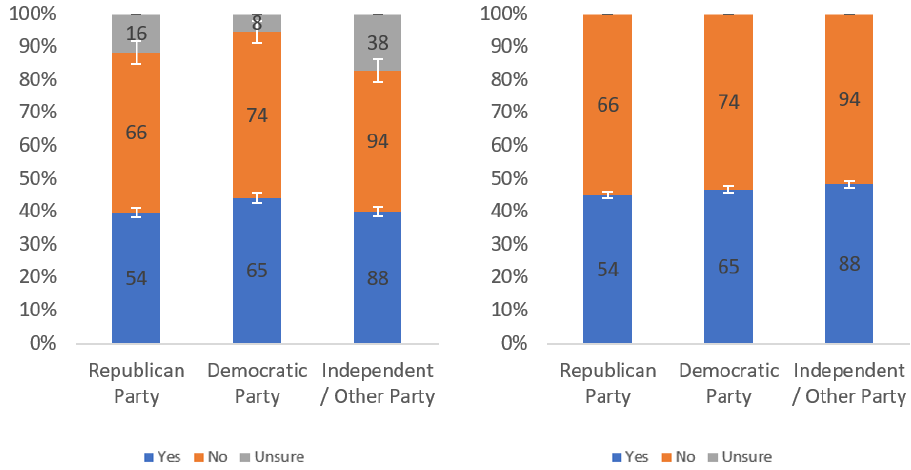
Figure A5. Responses regarding label annoyingness by party affiliation including ( left ) and excluding ( right ) unsure responses.